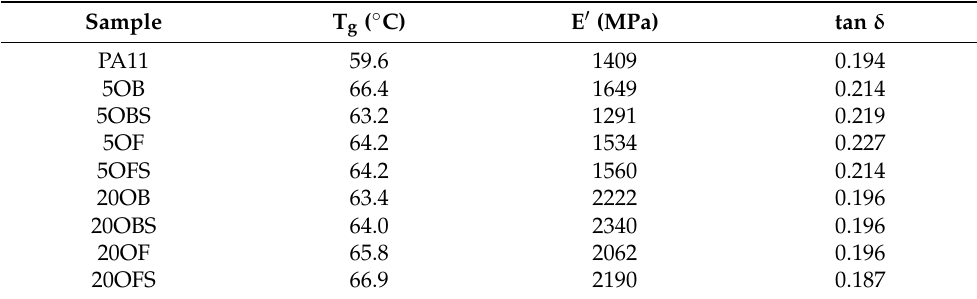
Table 6. Summary of the determined values of the glass transition temperature from tan δ curves and storage modulus E (cid:48)